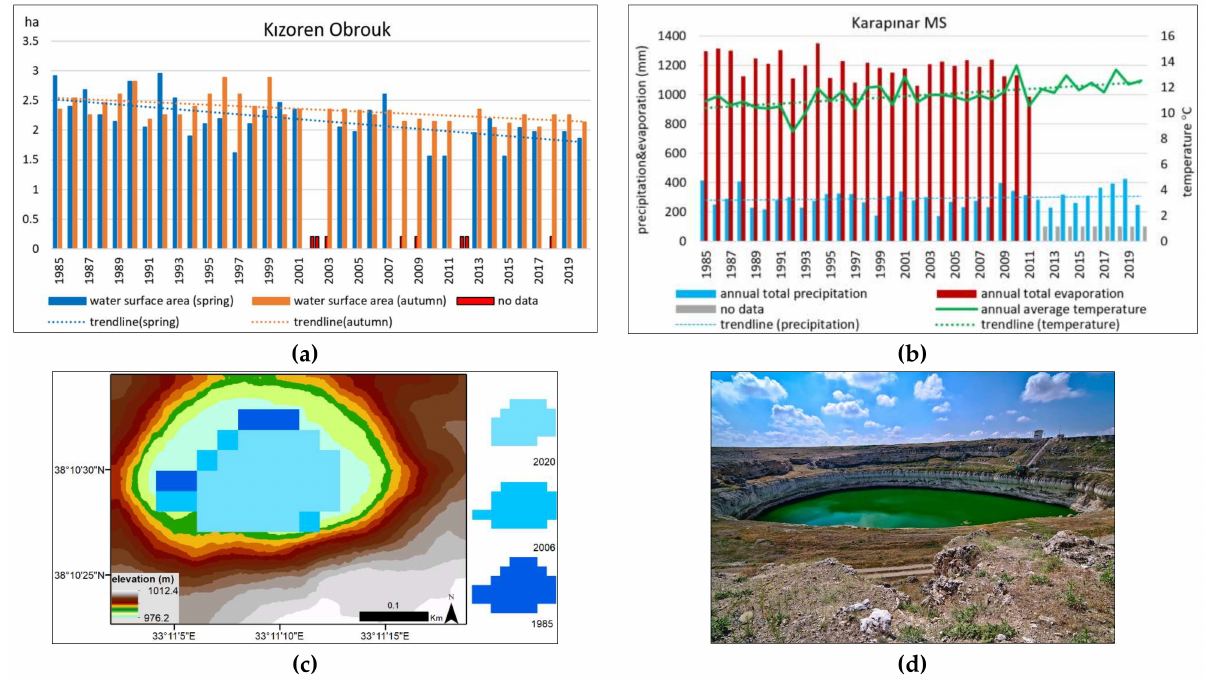
Figure 13. Kızoren Obrouk: ( a ) 1985–2020 annual (spring and autumn) surface water areas; ( b ) representative meteorological station data (precipitation, evaporation, and temperature); ( c ) water surface area changes (NDWI); ( d ) view of the site